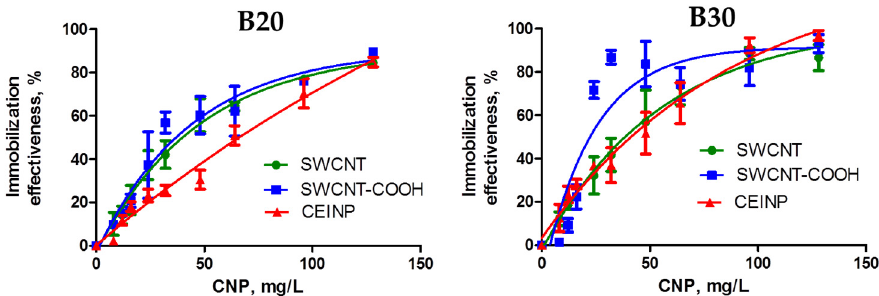
Figure 2. Isotherms of adsorption of oligonucleotides B20 and B30 on SWCNT, SWCNT-COOH, and CEINP surface. Conditions: 0.01 M phosphate buffer (pH 7.5), 1 µM oligonucleotides, detection of fluorescence at 380 nm.